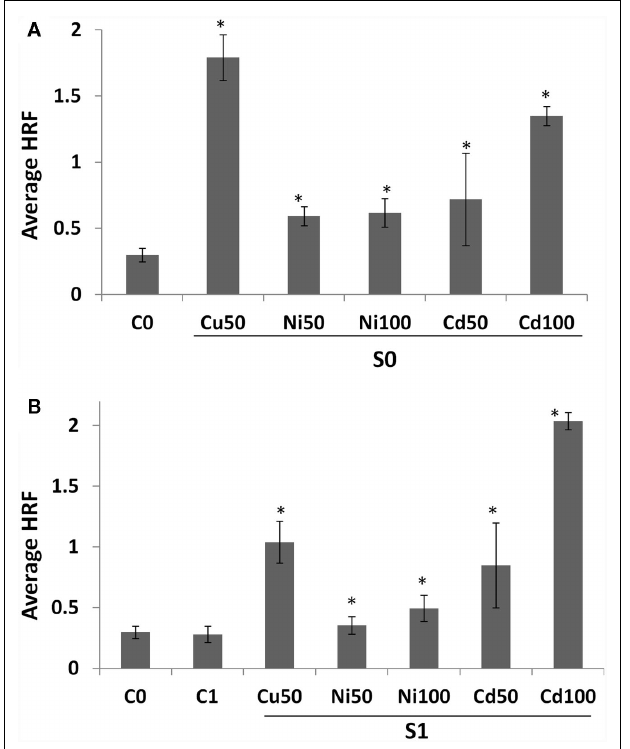
FIGURE 1 | Homologous recombination frequency (HRF) in somatic tissue and the progeny of stressed plants. (A) HRF is shown as an average of three independent experiments. Bars show SD. Asterisks indicate significant differences between individual treatment group and a control group (Student’s t -test, p < 0.05 in all cases). (B) HRF in the progeny of stressed and progeny of control plants (labeled as “G1”) is shown as an average of three independent experiments. HRF in somatic tissue of non-exposed plants (C0) is shown for comparison. Bars show SD. Asterisks indicate significant differences in HRF between individual G1 group and G0 untreated plants (C0; Student’s t -test, p < 0.05 in all cases). No significant difference between C0 and C1 groups were found ( p >